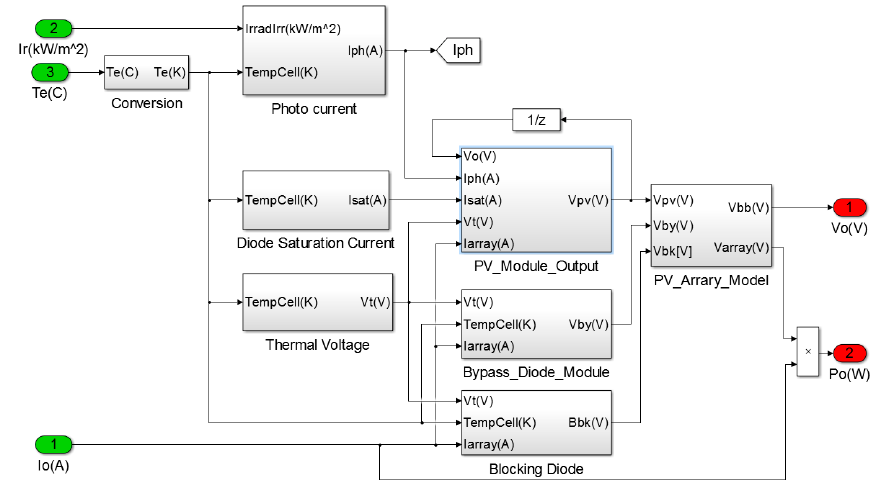
Figure 3. PV System array simulation model.